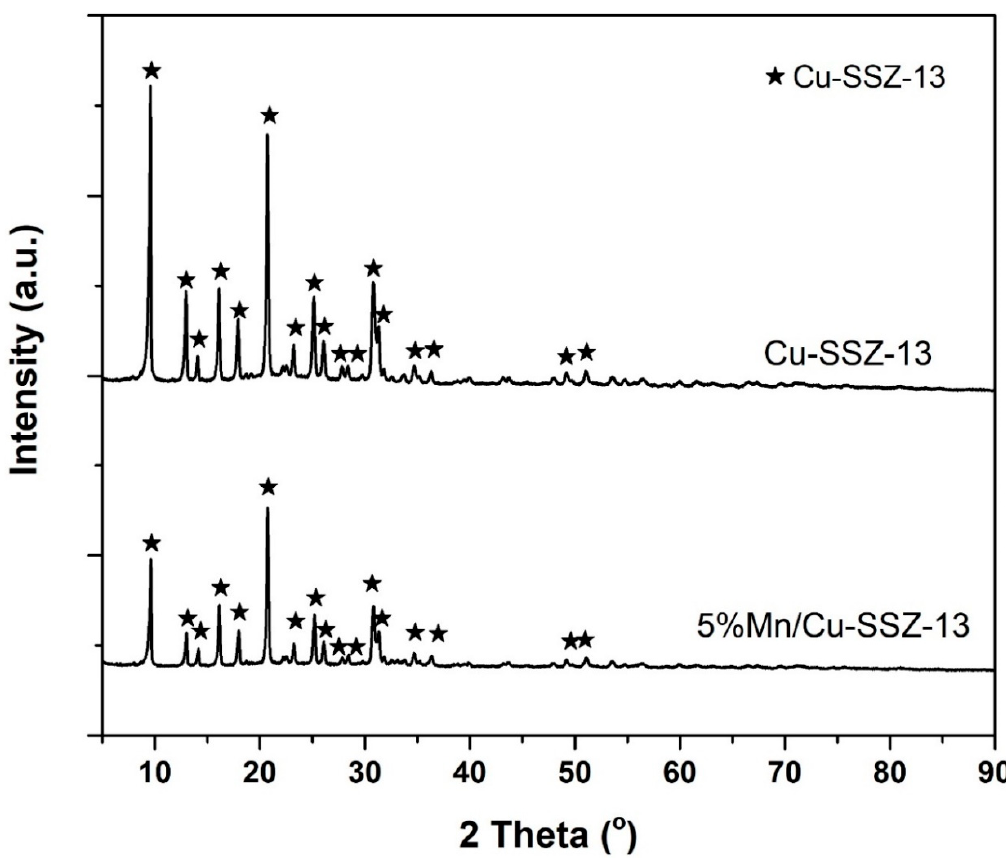
Figure 3. XRD patterns of Cu-SSZ-13 and 5% Mn/Cu-SSZ-13.